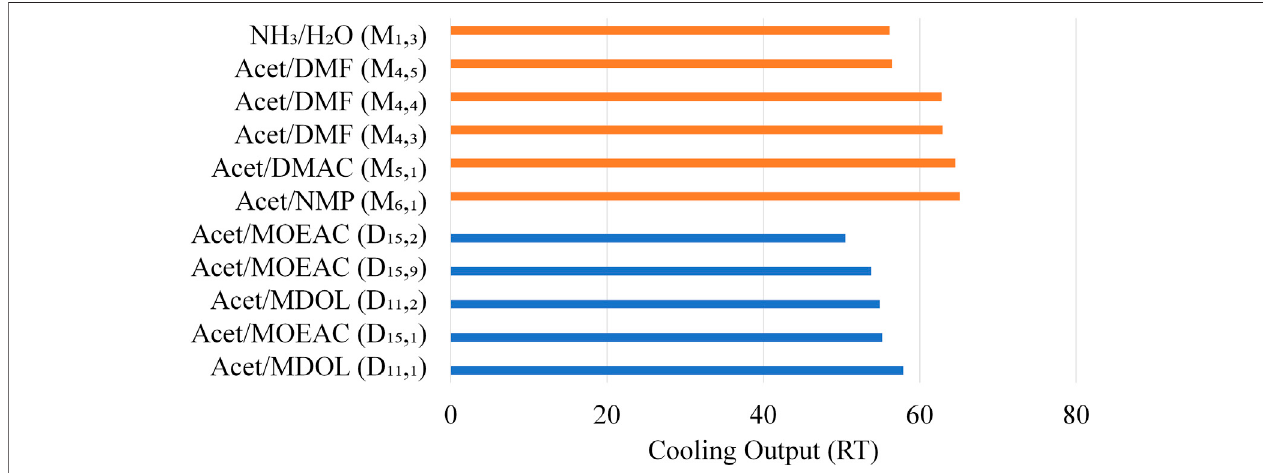
FIGURE 6 | Comparison of designed mixtures (denoted with “ D ” ) against the ones obtained from (Papadopoulos et al., 2020b) (denoted with “ M ” ) in terms of cooling output.